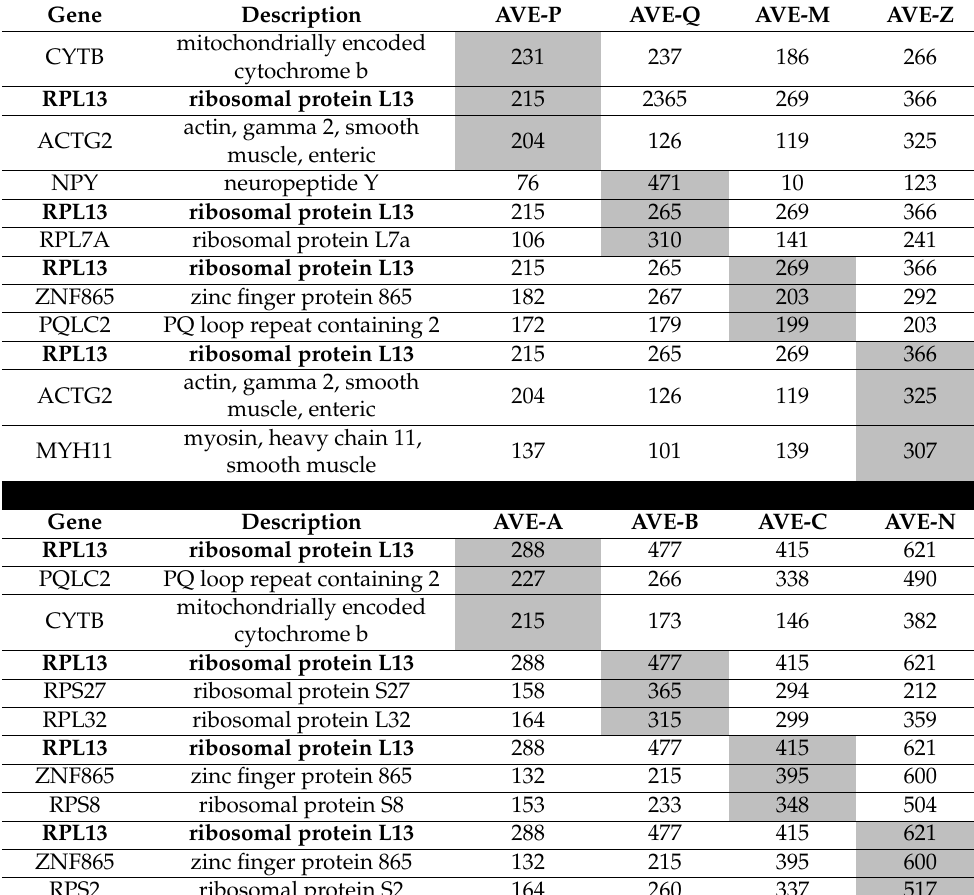
Table 1. Three genes with the largest average expression levels (AVE) in each of the four profiled regions of the “PQMZ” patient and in the four regions of the “ABCN” patient. The largest 3 AVE values in each phenotype have a gray